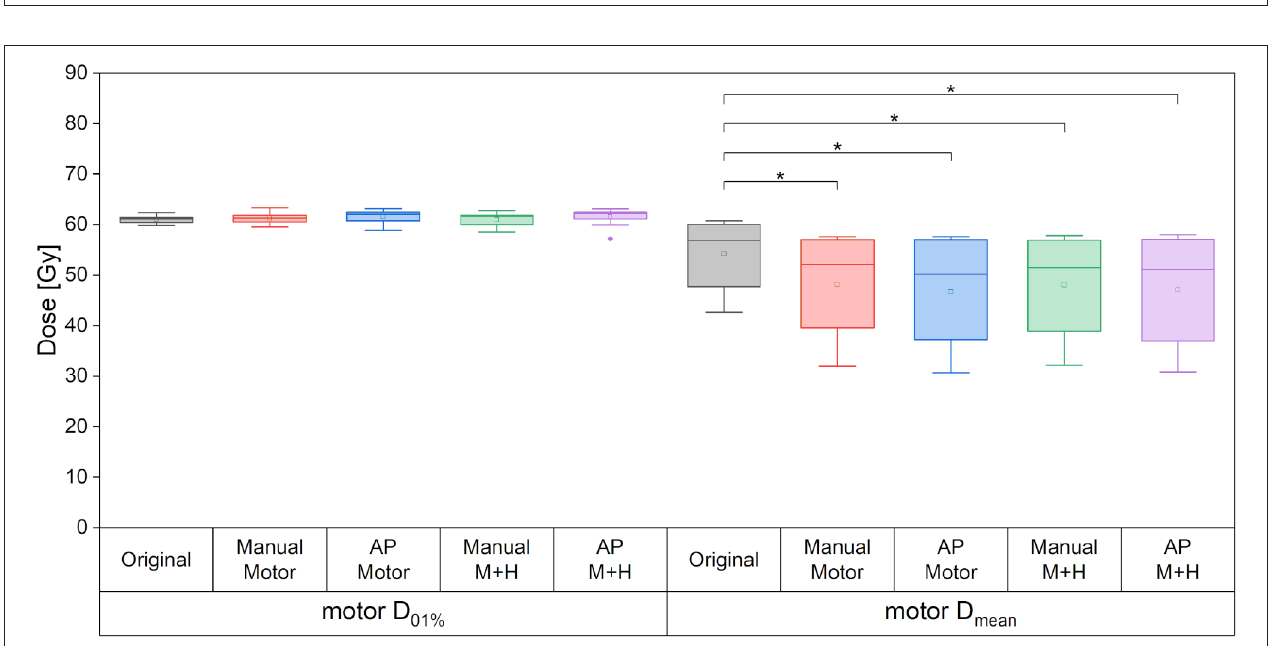
doses to the ipsilateral hippocampus, a significant improvement was observed in all re-optimized plans. The reduction of the